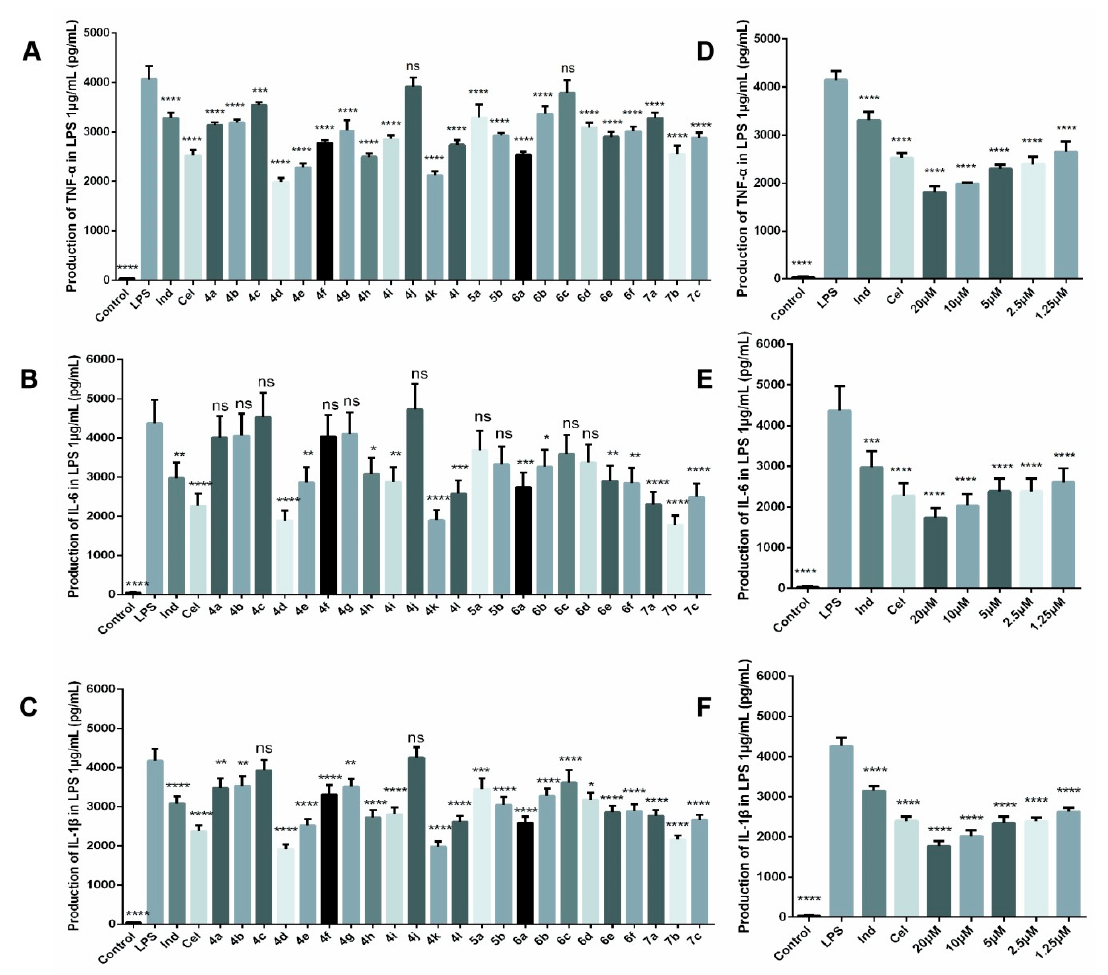
Figure 2. Initial evaluation releases of TNF- α , IL-6 and IL-1 β in RAW264.7 cells. TNF- α , IL-6 and IL-1 β in the culture medium were measured by ELISA. ( A – C ) Cells were treated with 10 µ M compounds. ( D – F ) Cells were pretreated with di ff erent concentrations of compound 4d . The levels of TNF- α , IL-6 and IL-1 β in the medium were determined with the ELISA kit. Indomethacin (Ind) and celecoxib (Cel) were used as a positive control drug. The results were presented as the means ± SD of three di ff erent experiments. The di ff erence was considered statistically significant when p (*) < 0.05, p (**) < 0.01, p (***) < 0.001, p (****) < 0.0001 compared with LPS-stimulated group.